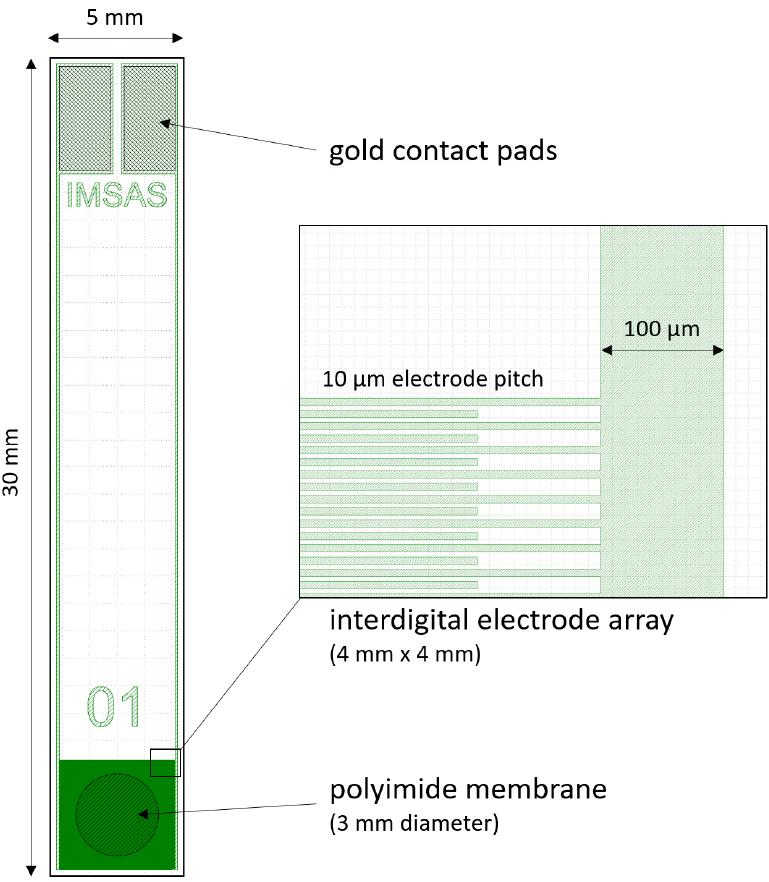
Figure 2. Design of the polyimide-based test sample. The enlarged cutout shows the interdigital gold electrode array with 5 µ m wide electrodes and 5 µ m spacing with a total area of 16 mm 2 . A 3 mm diameter polyimide membrane is located in the middle of the electrode array.